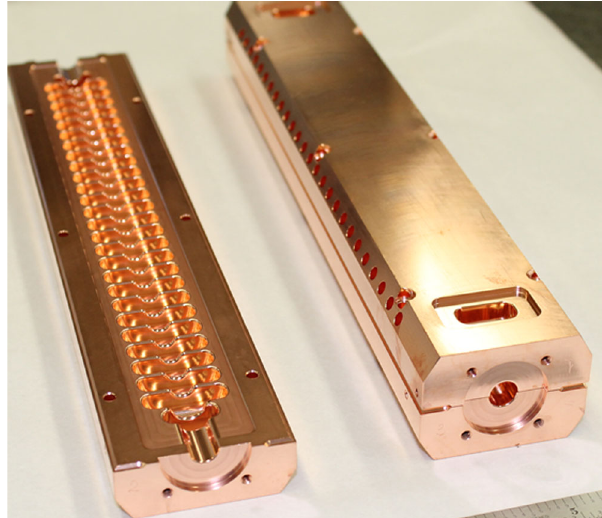
[11].FIG. 8. Photos of the CLIC-G-OPEN after milling and after installation